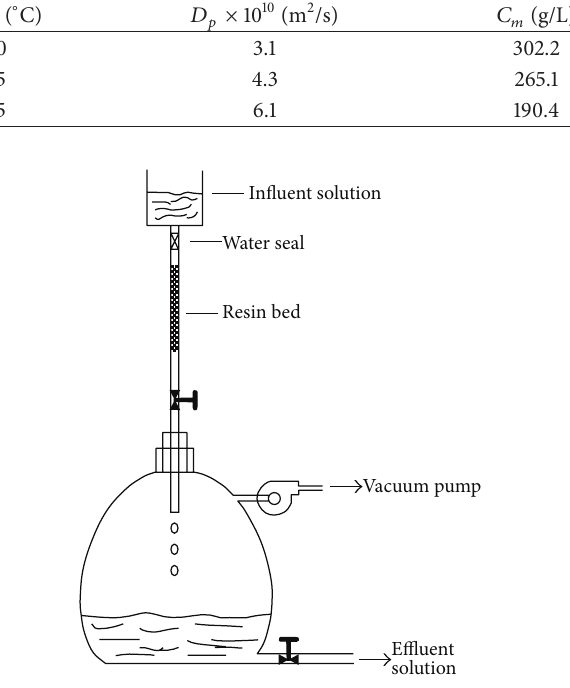
Figure 1: Schematic diagram of experimental apparatus